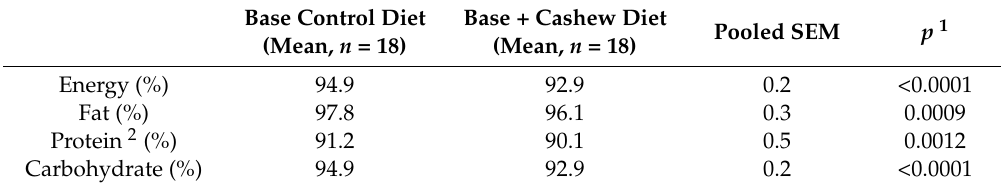
Table 5. Digestibility of the Base Control Diet and the Base + Cashew